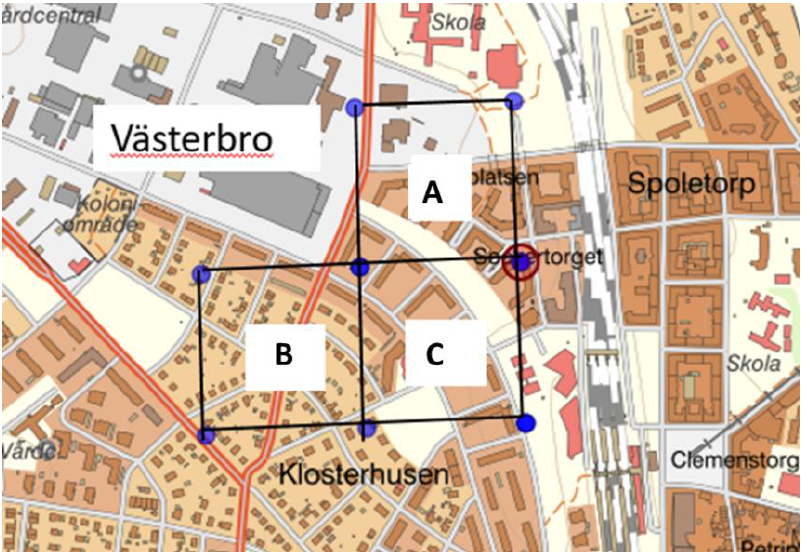
Figure A1. Three squares were used to approximate estimations of the population structure of the future Västerbro area. See text for explanation of square A, B and C.